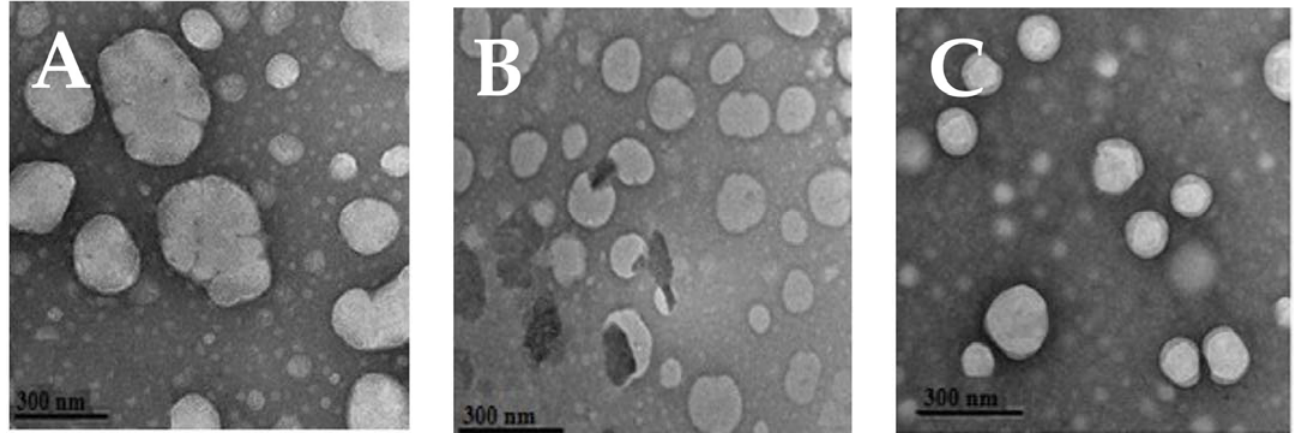
Figure 1. Transmission electron microscopy (TEM) of eugenol (EU) nano ‐ emulsion prepared with